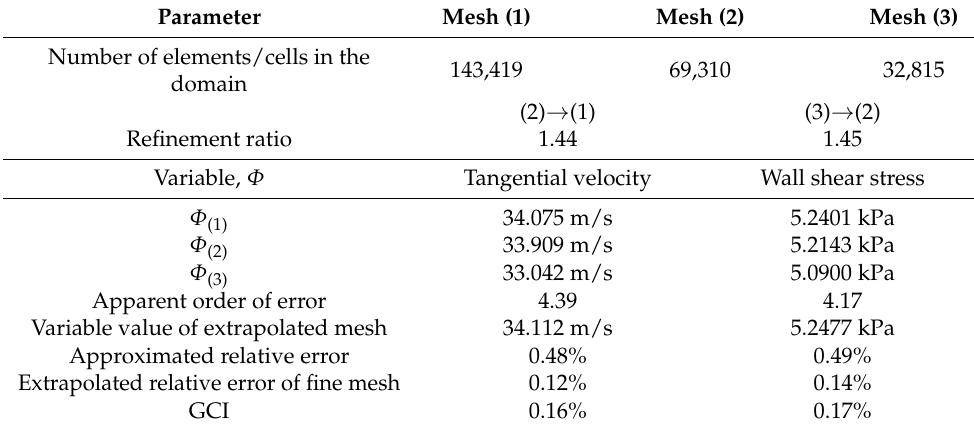
Table 1. Variables and respective values considered for the GCI analysis and calculated discretiza- tion